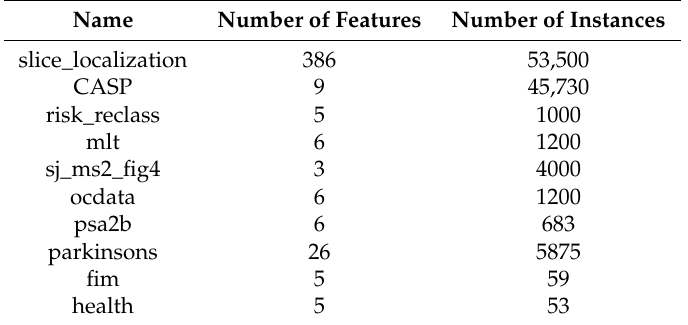
Table 2. Regression datasets.